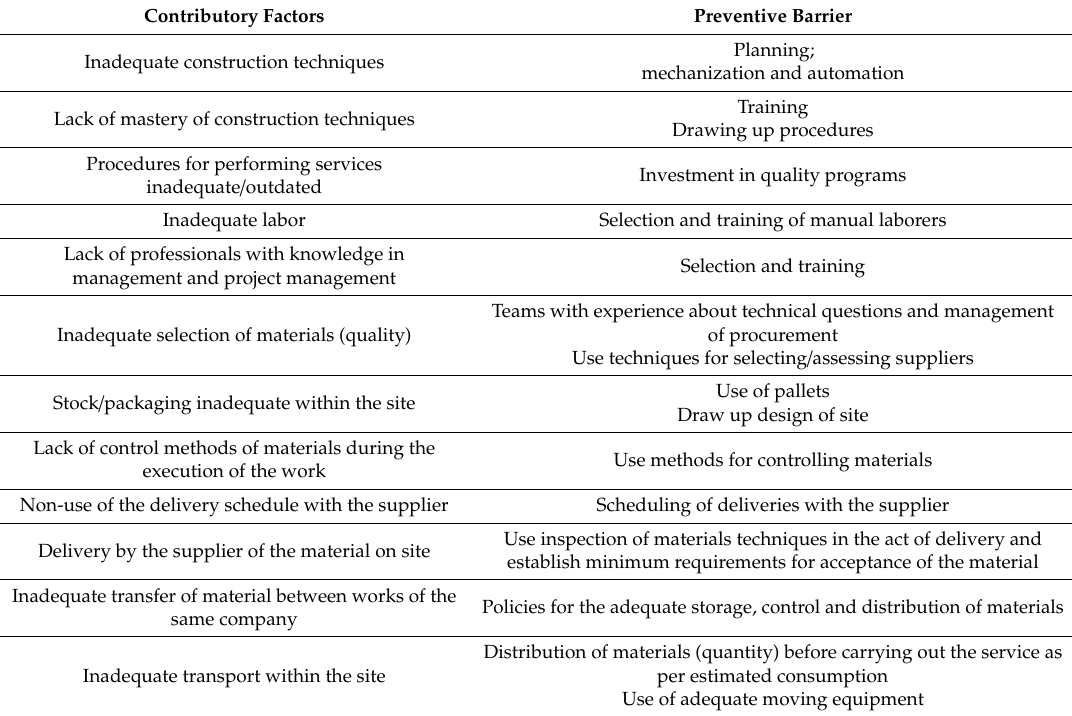
Table 2. Barriers to prevent the wastage of